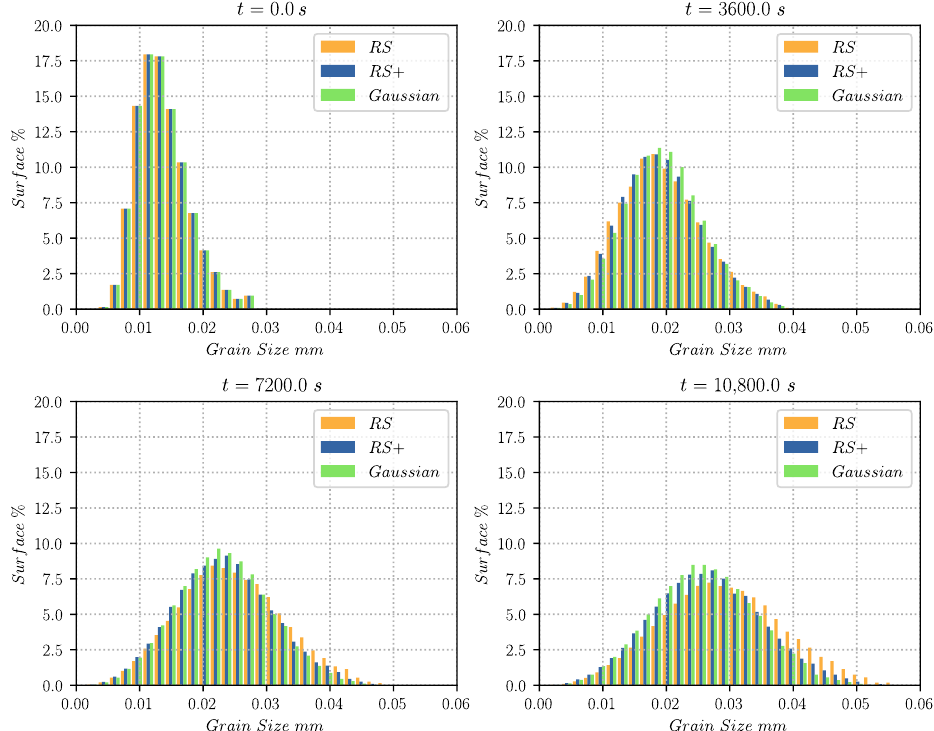
Figure 12. Grain size distributions weighted by surface using various functions for the computation of the GB energy γ . The distributions are given for every hour of thermal treatment. Each class of data contains the results of four different initial states representative of the same initial grain size distribution.